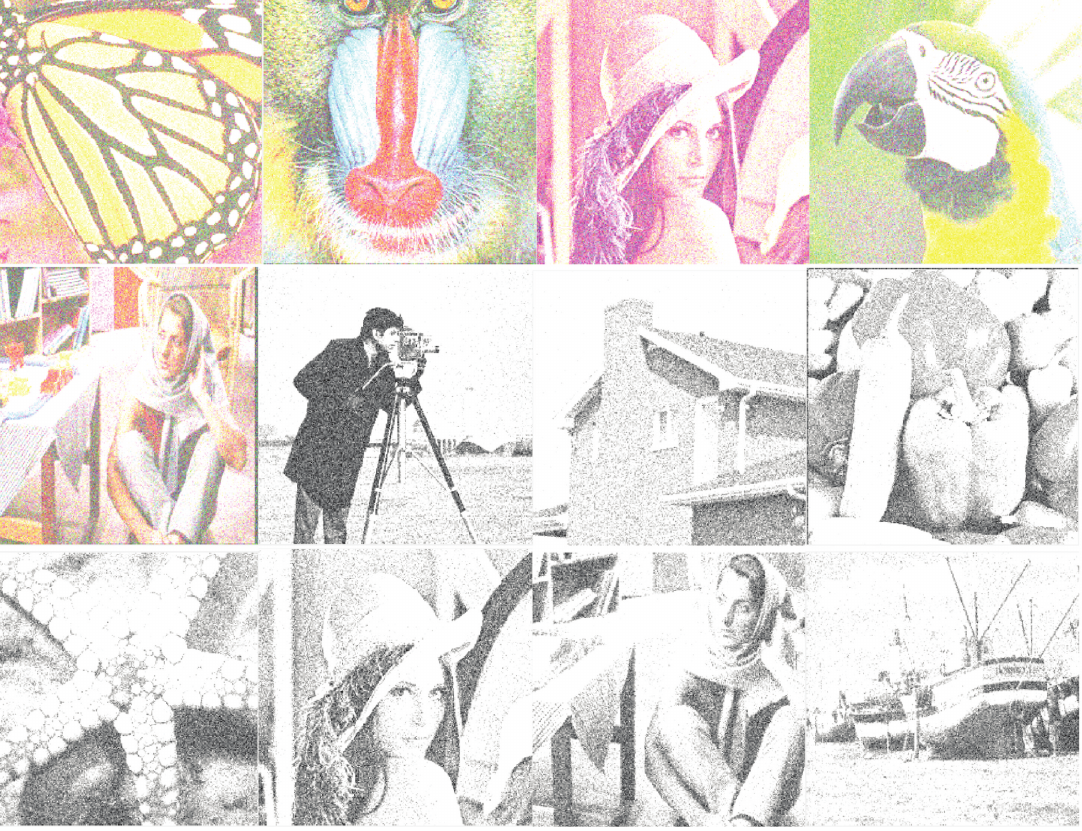
Figure 6: Noisy Images (Gaussian Noise in σ =